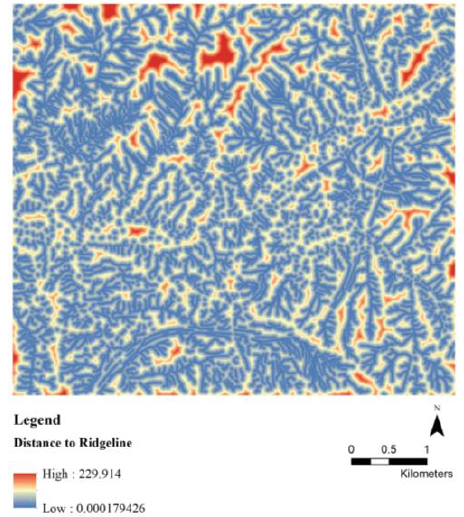
Figure 12. Distances to ridgelines.